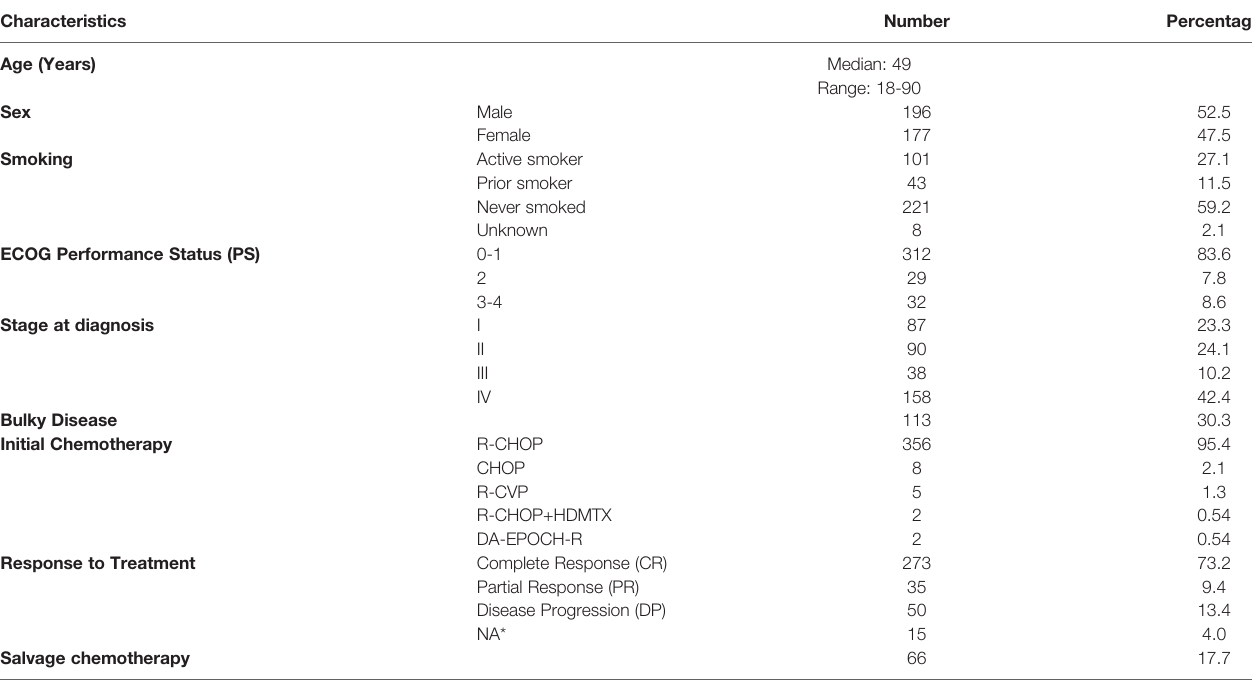
TABLE 1 | Patients ’ characteristics (n = 373).